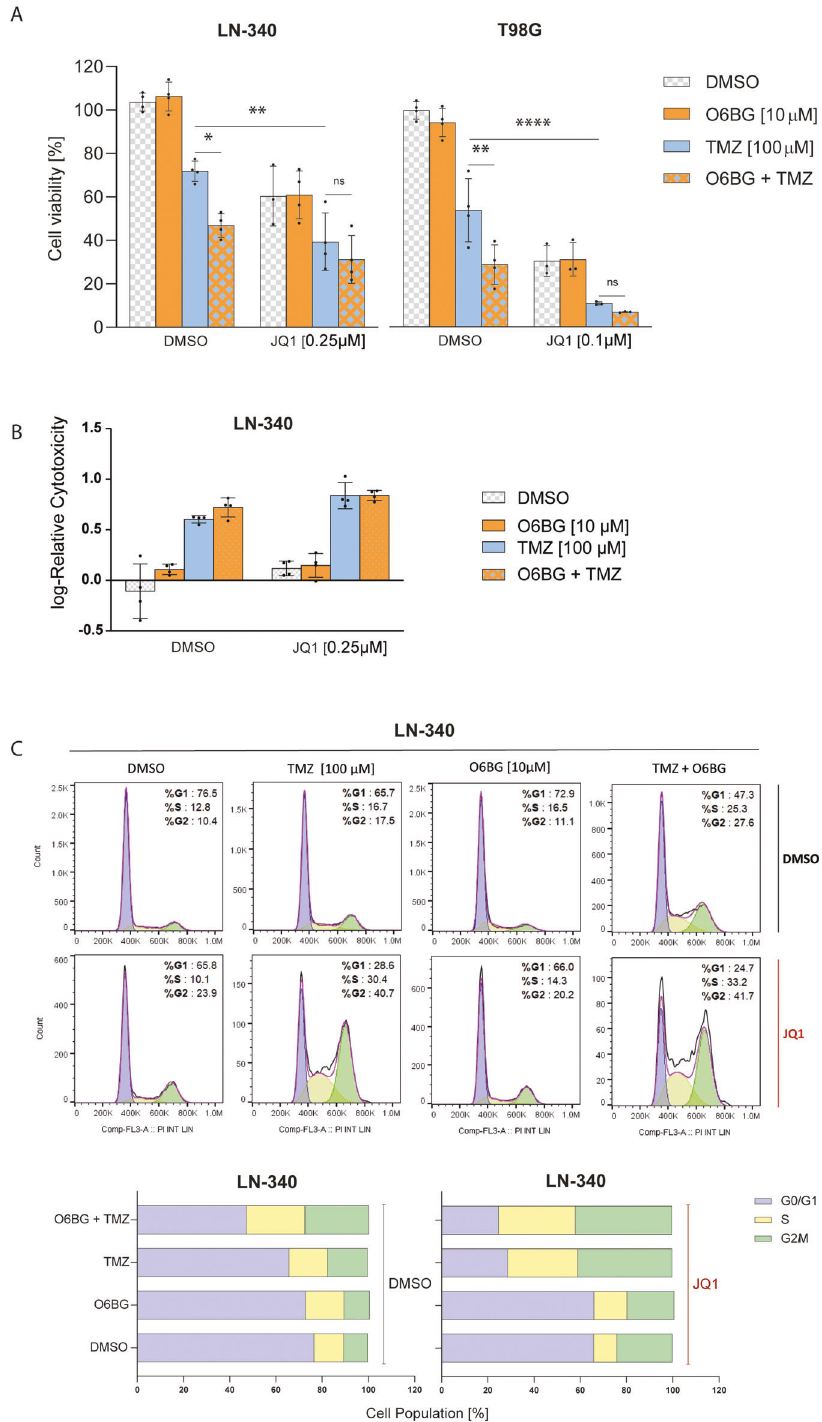
Fig. 5 BETi sensitizes GBM to TMZ. A Cell viability was assessed in LN-340, and T98G. Cells were treated with JQ1 for 5 days at [0.25 μ M] and [0.100 μ M], respectively. On day 5, cells were treated with O6BG [10 µM] alone, or together with TMZ [100 µM]. Two additional TMZ treatments were given every 6 h, for a total of 3 TMZ treatments on day 5. End-point was set at 96 h after TMZ treatments. Data represent mean of 4 biological replicates. Adjusted p- values were determined by Tukey ’ s multiple comparisons tests following additive mixed model including interaction between the treatments (TMZ, OB6G and JQ1). Error bars are SD. *( p ≤ 0.05), **( p ≤ 0.01), ****( p < P ≤ 0.0001). B Relative cell death (Cytotox Red / cell con fl uency; Incucyte Zoom) was evaluated using the treatment conditions described in ( A ) monitored by live imaging over 70 h post treatment, comparison at 70 h. The mean of 4 biological replicates is shown. For stabilization and normal distribution of the data, log10-transformation was performed (Spearman correlation: -0.2423). C Analysis of the effect of JQ1 on the cell cycle pro fi le of TMZ treated LN-340 cells was performed by FACS analysis using DAPI staining and subsequent fl ow cytometry cell cycle analysis using FlowJo. Cells were treated as in ( A ) and analyzed 48 h after TMZ treatment. Data represent 1 representative biological replicate.